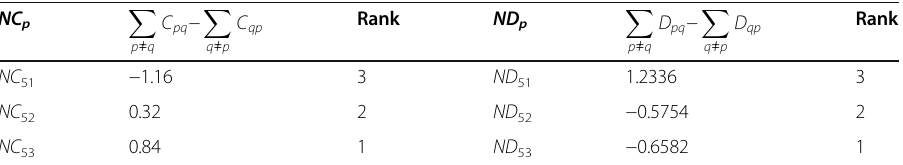
Table 17 Net concordance and discordance